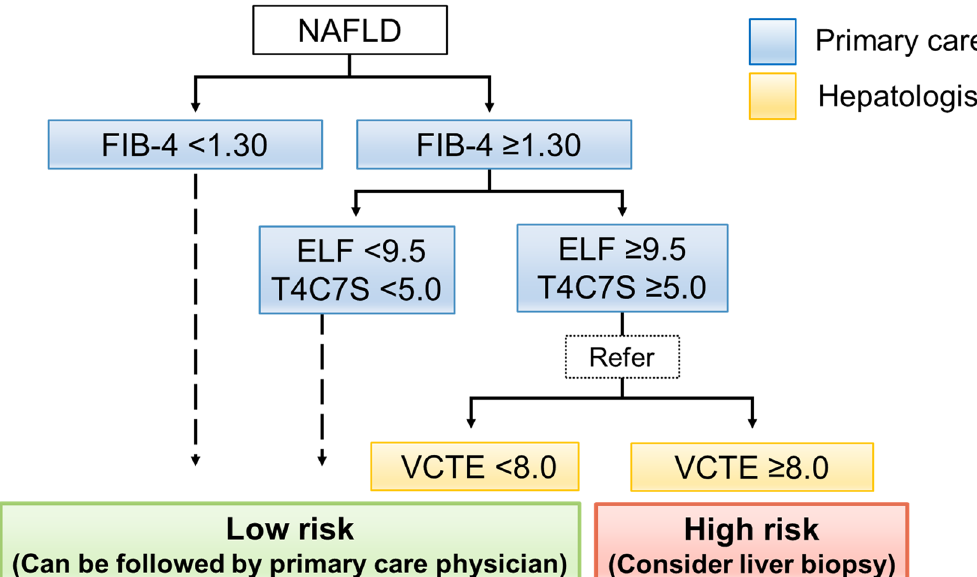
Figure 3. Our novel 3-step approach. The application of this approach will increase the number of patients seen by primary care physicians and decrease the number of specialist referrals. Patients considered at low risk using this approach only need to be followed up by a primary care physician, whereas those considered at high risk need to undergo additional evaluations, including liver biopsy. ELF, enhanced liver fibrosis test; FIB-4, Fibrosis-4 index; T4C7S, type IV collagen 7S domain; VCTE, vibration-controlled transient